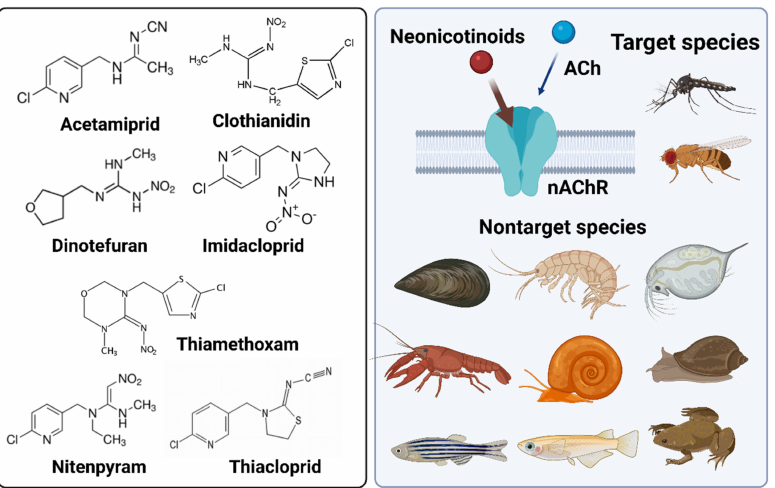
Figure 1. Summary of common neonicotinoids and invertebrate and vertebrate animal models used to test it’s in vivo toxicity. The chemical structures of seven common neonicotinoid pesticides were listed in the left panel. The working mechanism and common animal models used to study neonicotinoid toxicity were listed in the right